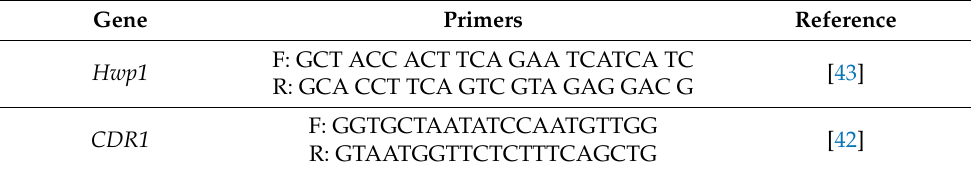
Table 1. Primers used for